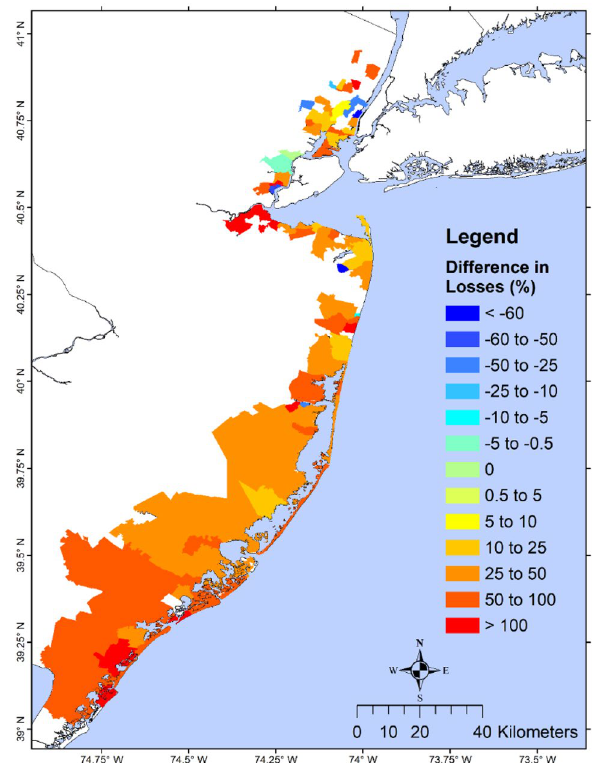
Figure 4. Effect of wetlands on structural losses over zip code scale during the 1% annual event. Map showing zip code resolution difference in losses if the wetlands were absent, as a percentage of the wetland present scenario. Dark red values show zip code with the highest benefit of having wetlands while dark blue areas show the least benefited area. Negative values indicate that the presence of wetland would increase structural losses and positive values indicate that wetland would lower the structural losses. The map is produced using ESRI ArcGIS Pro 2.7 (https ://www.esri.com/en-us/arcgi s/produ cts/arcgi s-pro/overv